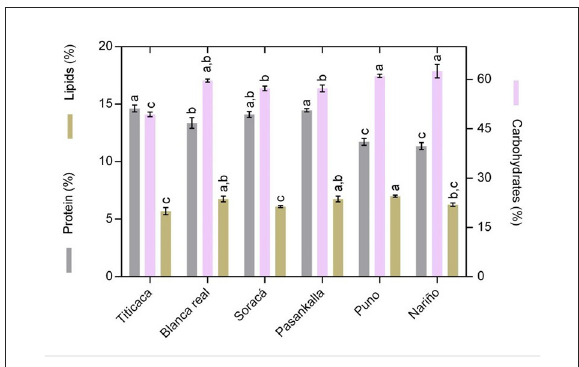
FIGURE1 Protein, lipid and carbohydrate content. The average with different letters shows significant difference ( p < 0.05).